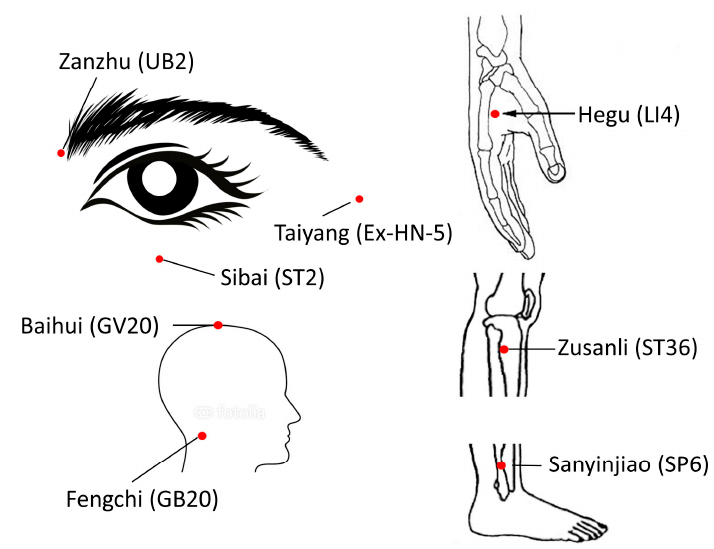
Figure 2. Acupuncture points for group A (acupuncture treatment). UB2 = Urinary Bladder 2; ST2 = Stomach 2; Ex-HN-5 = Extra Point Head/Neck 5; GV20 = Governing Vessel 20; GB20 = Gallbladder 20; LI4 = Large Intestine 4; ST36 = Stomach 36; SP6 = Spleen 6.